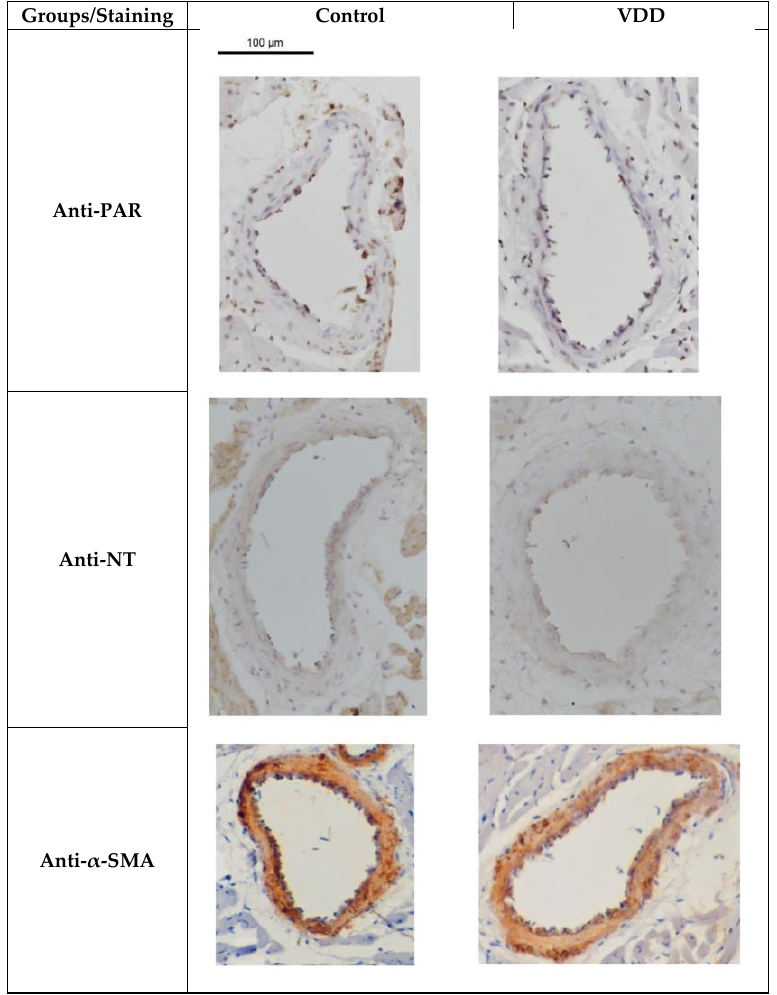
Figure 7. Representative photos of poly(ADP)-ribose (PAR), 3-nitrotyrosine (NT), and -smooth muscle actin (α-SMA) immunohistochemistry sections of male rat coronary arteriole segments. Scale bar, 100 μm. Abbreviation: VDD = Vitamin-D-deficient.